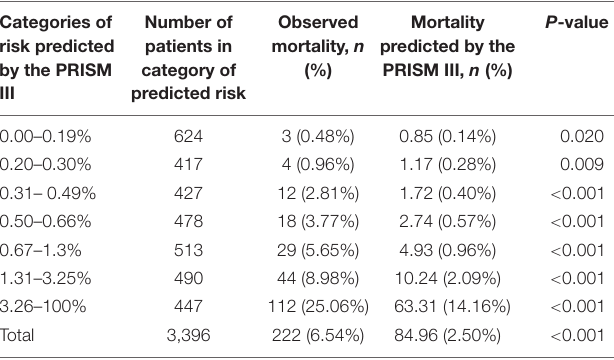
TABLE 3 | Mortality observed and predicted per category of predicted risk for the Pediatric Risk of Mortality III*.